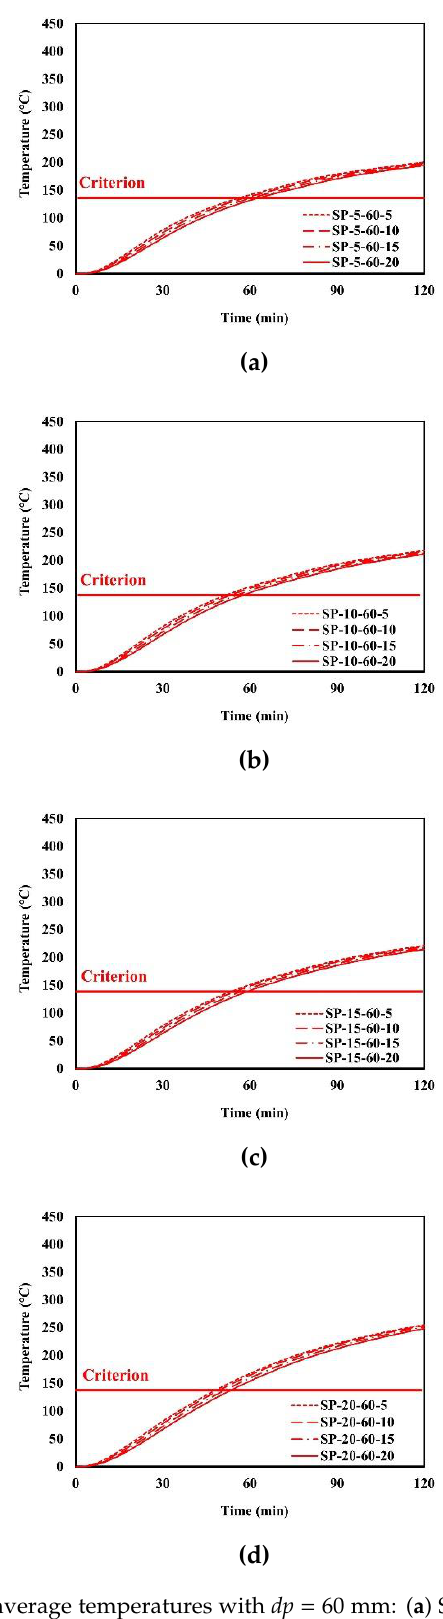
Figure 17. Time history of maximum Figure 18. Time history of average Figure 18. Time history of average temperatures with dp = 60 mm: ( a ) SP-5-60-x; ( b ) SP-10-60-x; ( c ) temperatures with dp = 60 mm: ( a ) SP-5-60- temperatures with dp = 60 mm: ( a ) SP-5-60- SP-15-60-x; ( d ) x; ( b ) SP-60-20-x; ( c ) SP-15-60-x; ( d ) SP-20- x; ( b ) SP-10-60-x; ( c ) SP-15-60-x; ( d ) SP-20- 60-x. 60-x.